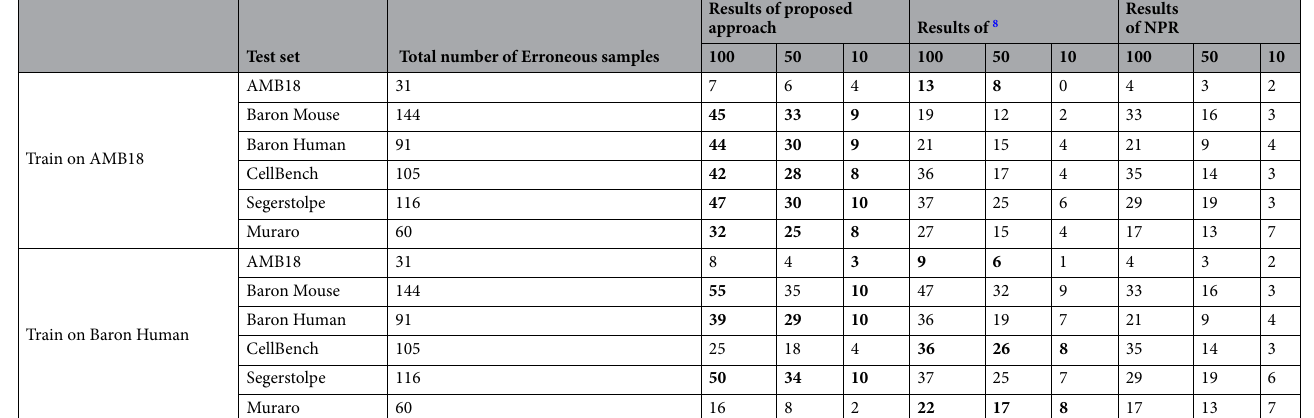
Table 2. The number of erroneous samples in the 100, 50, and 10 lowest confidence scores based on our top seven distance measures, scores from 8 and the NPR scores. RF scores are obtained from training on AMB18 and Baron Human datasets and tested on all test sets. Bold numbers indicate the best results for each test set. The top performances are indicated in